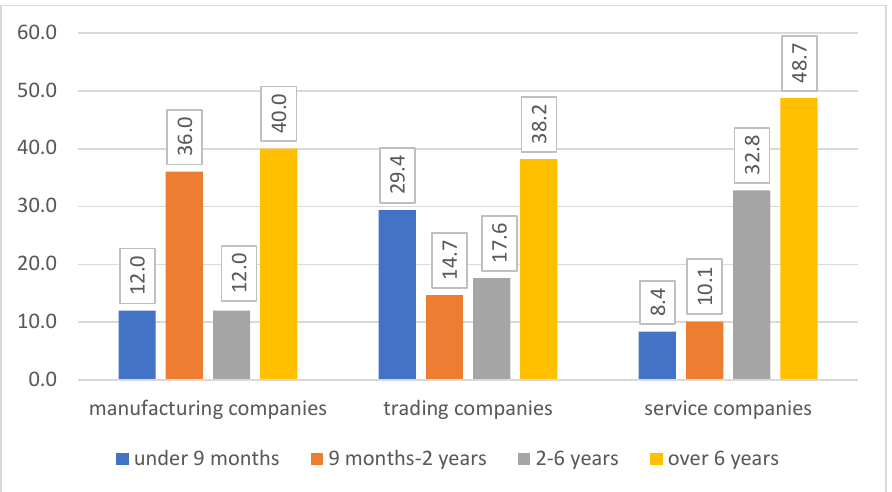
Figure 3. Respondents’ seniority (percentage) in different types of companies. Source: own elabora- tion based on the results of the study.